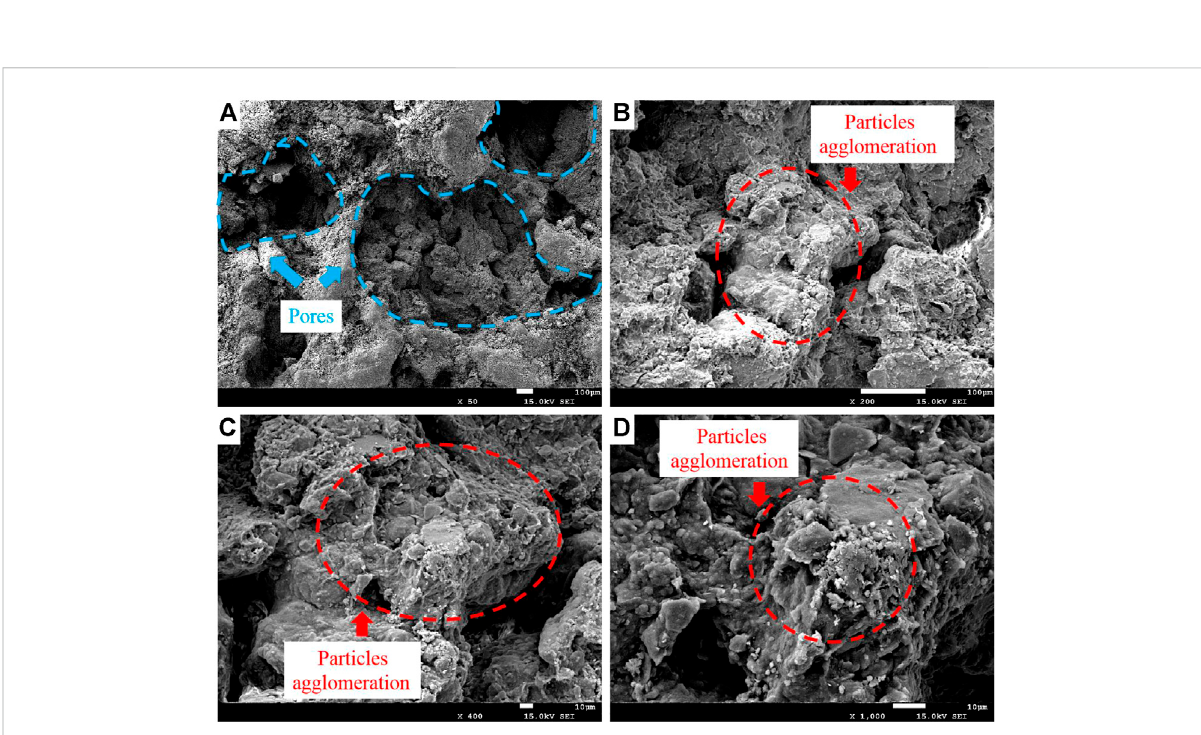
FIGURE 8 Electron microscopic scanning of the sample at non-disease segment: (A) Sample No.5 – 50 times, (B) sample No.5 – 200 times, (C) sample No.5 – 400 times, (D) sample No.5 – 1,000